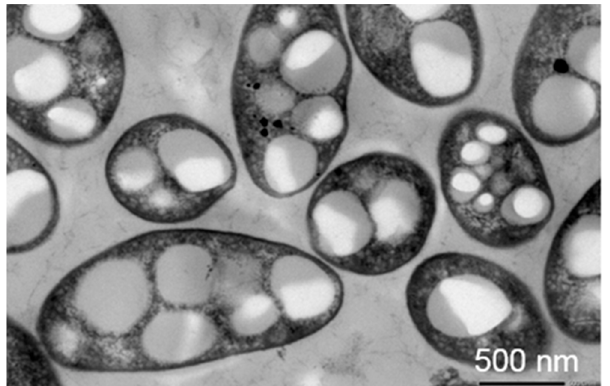
Figure 4. TEM image of Rhodovulum visakhapatnamense accumulating intracellular PHA granules, appearing as whitish and bright areas (adapted from Reference [25]).